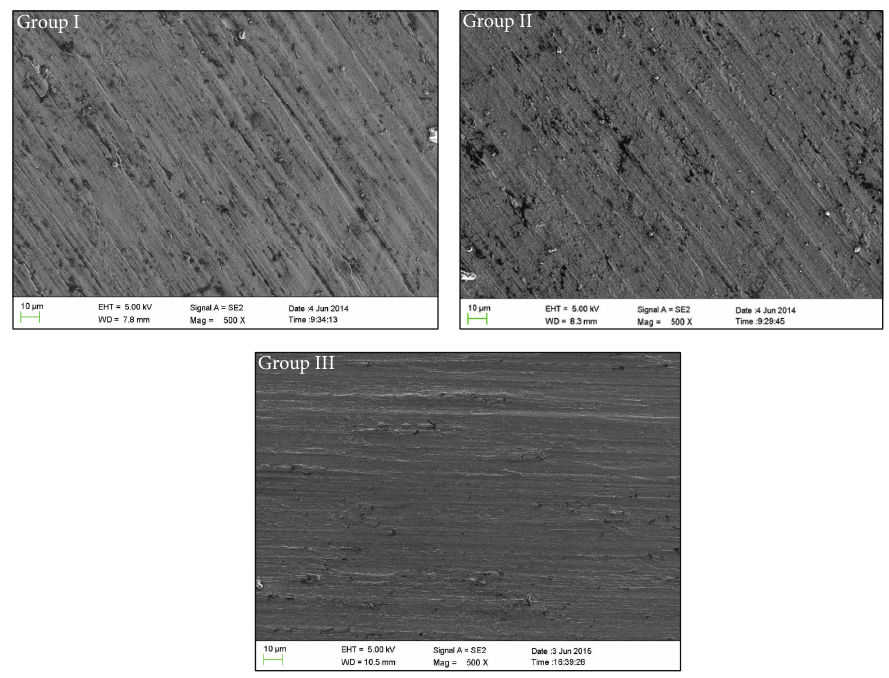
Figure 2: Images of surface morphology during turning under different gas